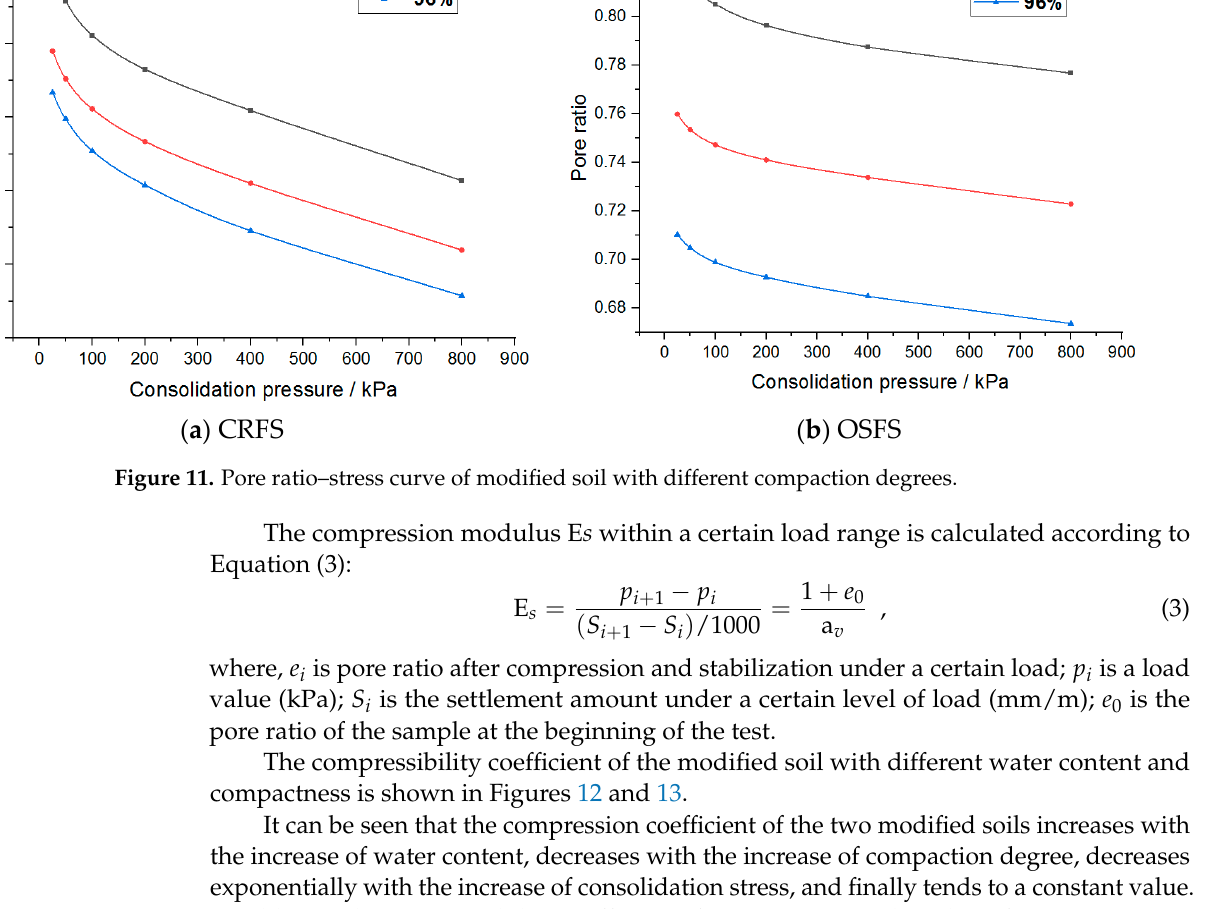
Figure 11. Pore ratio–stress curve of modified soil with different compaction degrees.